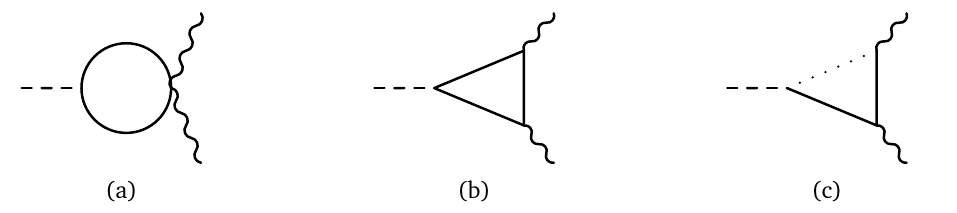
Figure 1: Standard Model diagrams contributing to Higgs boson decays to two pho- tons and a Z boson and photon. In (a) and (b) the solid line represents the contribu- tion of either W –bosons, the charged goldstone bosons, charged ghosts, or fermions. In the case of the HZ γ coupling loops can be composed of one goldstone boson and two W –bosons or two goldstone bosons and one W . This is illustrated in Figure (c) where the solid line may represent W –bosons while the dotted line represents gold- stone bosons, or vice versa.